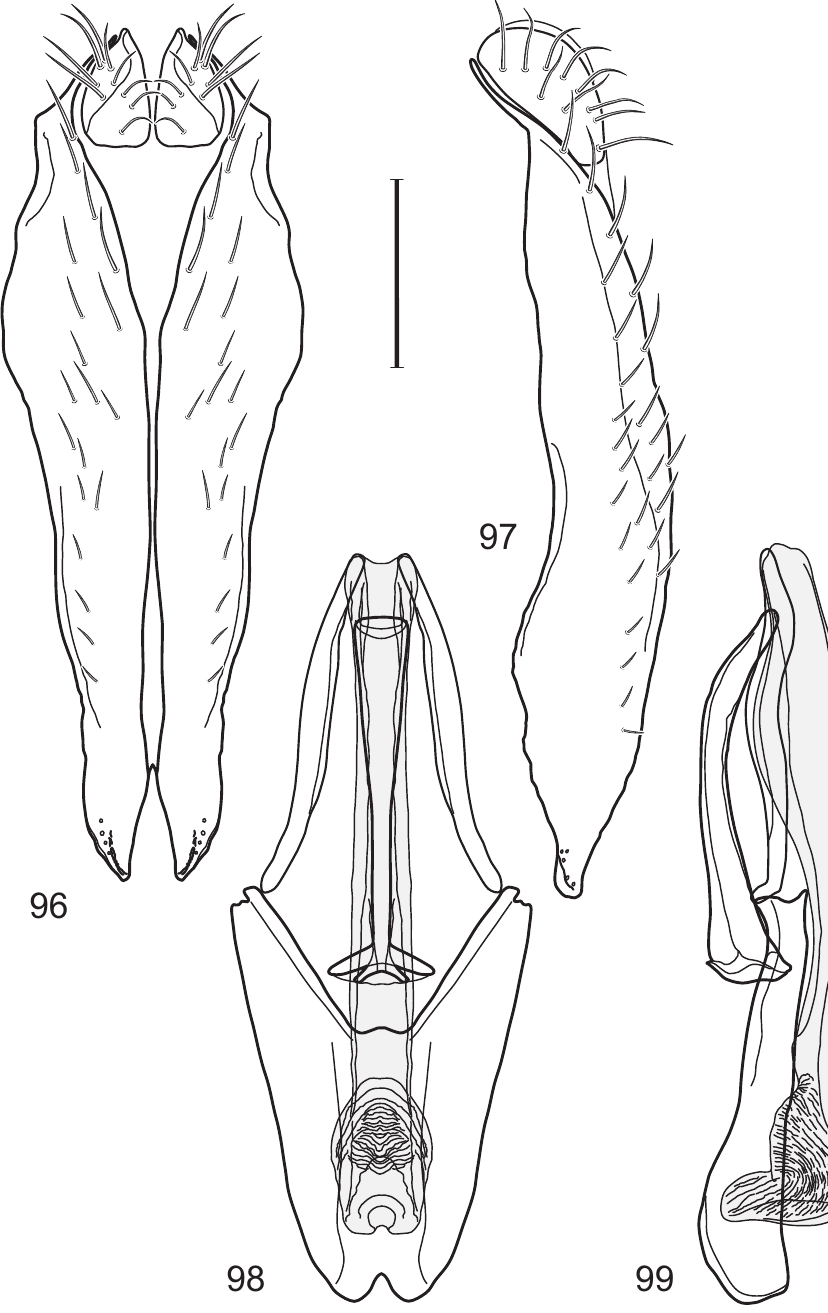
Figures 96–99. Hydrochasma kaieteur sp. n. (Guyana: Dubalay Ranch, Berbice River) 96 epandrium and cerci, posterior view 97 same, lateral view 98 internal structures of male terminalia (aedeagus [shaded], phallapodeme, gonite, hypandrium), ventral view 99 same, lateral view. Scale bar = 0.1